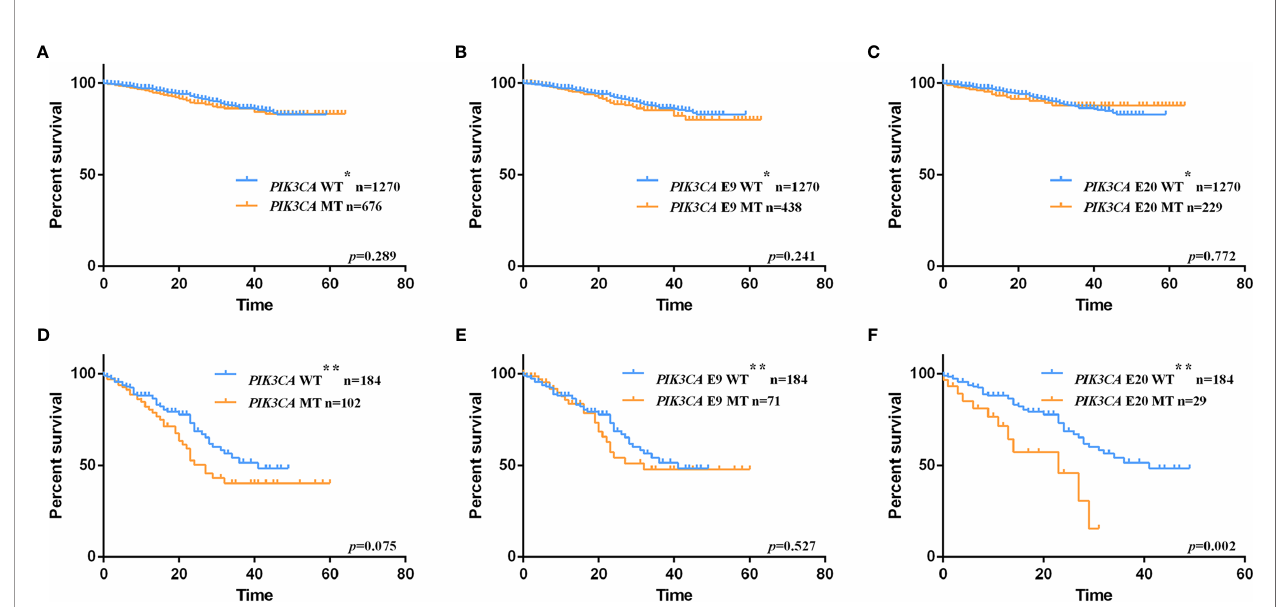
FIGURE 2 | Kaplan-Meier plots of overall survival (OS) for CRC patients with and without PIK3CA mutation. (A) at all stage, patients with PIK3CA mutation vs. patients with wild-type allele, p -value = 0.289; (B) at all stage, patients with exon 9 mutation vs. patients with wild-type allele, p -value = 0.241; (C) . at all stage, patients with exon 20 mutation vs. patients with wild-type allele, p -value = 0.772; (D) at stage IV, patients with PIK3CA mutation vs. patients with wild-type allele, p -value = 0.075; (E) at stage IV, patients with exon 9 mutation vs. patients with wild-type allele, p -value = 0.527; (F) at stage IV, patients with exon 20 mutation vs. patients with wild-type allele, p -value = 0.002. WT* represents stage I-IV wild-type patients with neither exon 9 nor exon 20 mutations. WT** represents stage IV wild-type patients with neither exon 9 nor exon 20